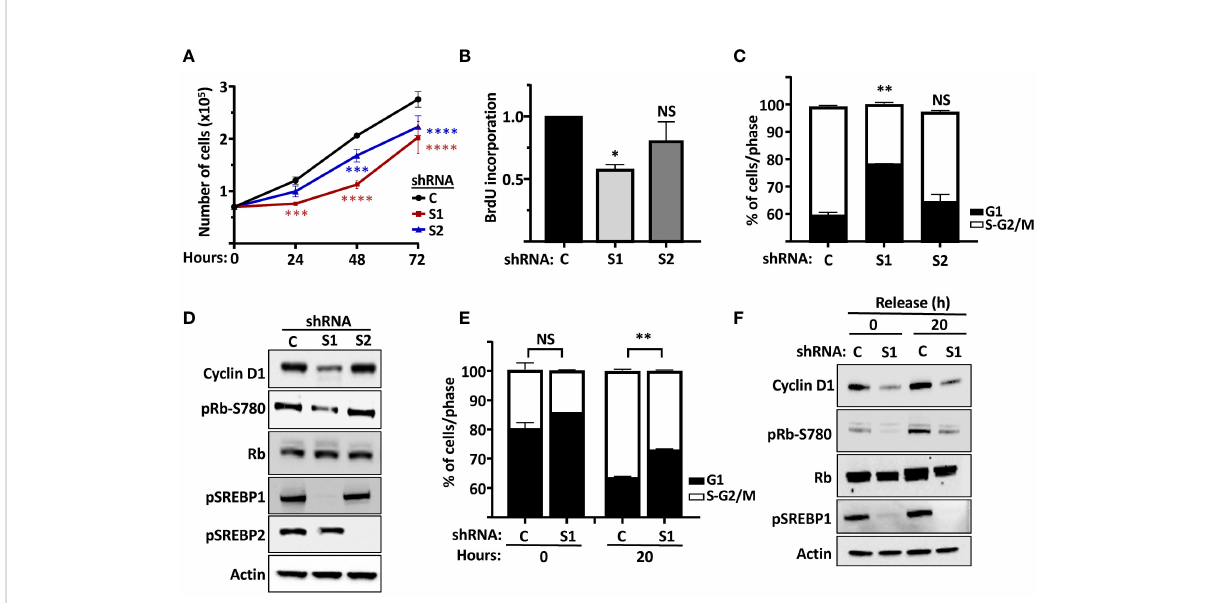
FIGURE 6 The SREBP pathway regulates the proliferation of MCF7 cells. (A) MCF7 cells were transduced with lentiviruses expressing non-targeted shRNA (C) or shRNA targeting SREBP1 ( S1 ) or SREBP2 (S2) . After selection, an equal number of cells were seeded in 12-well plates and cells counted over a 72-h period. (B) MCF7 cells were transduced with lentiviruses expressing non-targeted shRNA (C) or shRNA targeting SREBP1 ( S1 ) or SREBP2 ( S2 ) and metabolically labeled with BrdU, and the incorporation of BrdU was determined by an ELISA assay. (C) MCF7 cells were transduced with lentiviruses expressing non-targeted shRNA (C) or shRNA targeting SREBP1 ( S1 ) or SREBP2 ( S2 ). The cells were collected, fi xed, and stained with propidium iodine, and the DNA content was analyzed by FACS. (D) The same cells as in (C) were lysed and the levels of cyclin D1, Rb, and the precursor form of SREBP1 ( pSREBP1 ), and the phosphorylation of Rb on serine 780 ( pRb-S780 ) were analyzed by Western blotting. b -Actin was used as loading control. (E) MCF7 cells were transduced with lentiviruses expressing non-targeted shRNA (C) or shRNA targeting SREBP1 ( S1 ). After selection, the cells were serum-starved for 24 h, followed by an additional 20-h incubation in the absence or presence of serum. The cells were collected and processed as in (C) . (F) The same cells as in (E) were lysed and the levels of cyclin D1, Rb